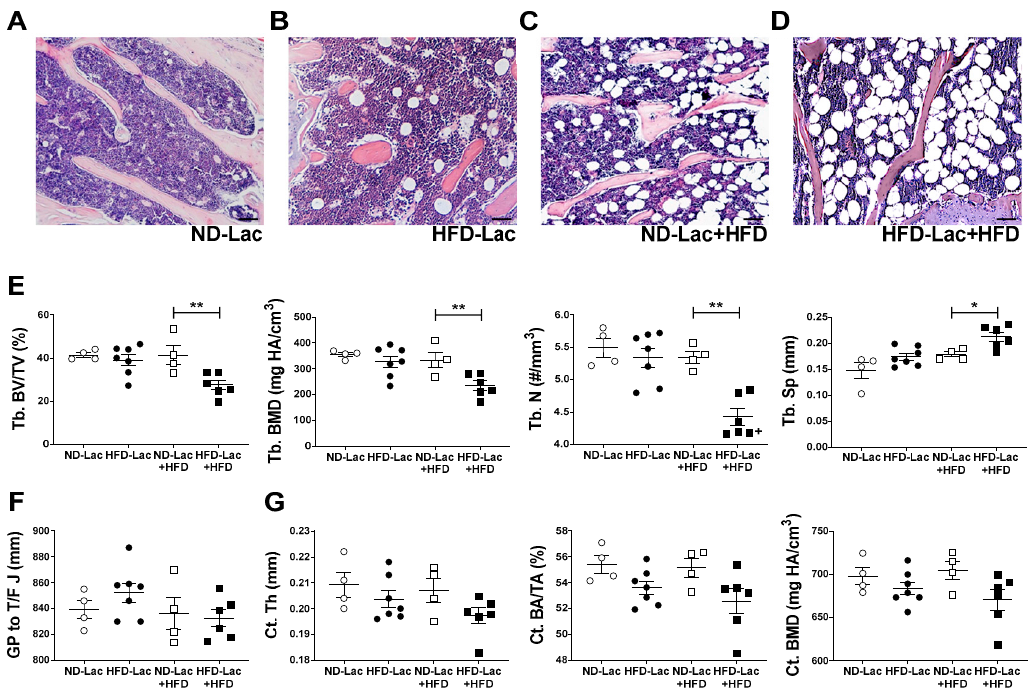
Figure 5. HFD re-challenge after exposure to HFD during lactation causes long-term bone loss and expansion of bone marrow adiposity. Representative sections of proximal tibiae from ( A ) ND-Lac, ( B ) HFD-Lac, ( C ) ND-Lac + HFD, and ( D ) HFD-Lac + HFD mice were stained with H&E and are shown at 100 × magnification; scale bar, 100 µ m. Tibial trabecular bone volume fraction (Tb. BV / TV), bone mineral density (Tb. BMD), trabecular number (Tb. N) and separation (Tb. Sp) were measured with µ CT ( E ). Tibial length was approximated by the distance from the growth plate (GP) to the tibia / fibula junction (T / F J) ( F ). Mid-tibia cortical bone area (Ct. BA / TA), thickness (Ct. Th), and bone mineral density (Ct. BMD) were also measured with µ CT ( G ). * p < 0.05, ** p < 0.01. + indicates a significant interaction between lactation exposure and HFD re-challenge.